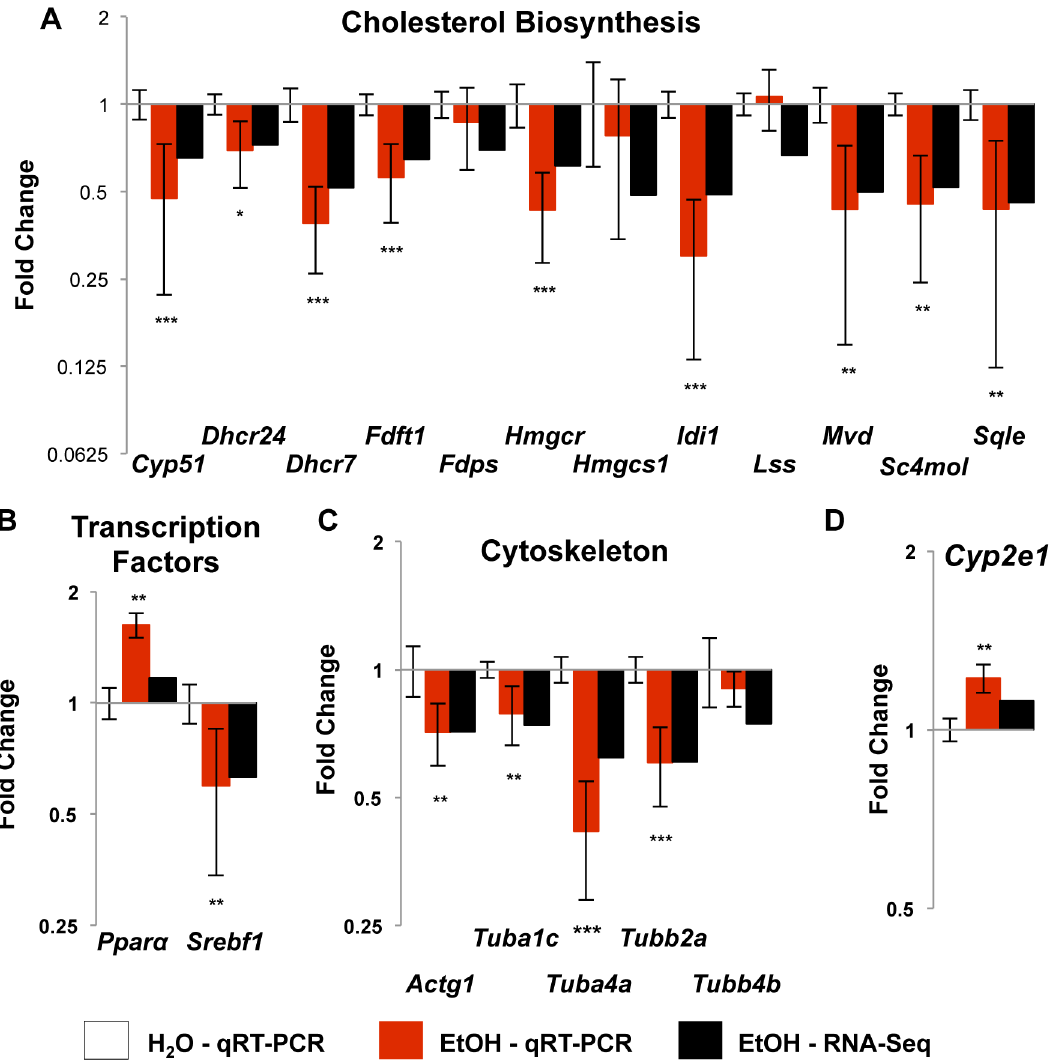
Fig. 3. Confirmation of altered expression by qRT-PCR in functional pathway genes. Taqman-based qRT-PCR was used to confirm the changes in gene expression. These graphs display the fold change ( ¡ SEM) of the candidate genes by qRT-PCR (red bars) and RNA-Seq (black bars) analysis for comparison. Numbers are relative to the water treated control rats (set at 1.0). ( A ) Nine of twelve genes in the cholesterol biosynthesis pathway were confirmed. ( B ) Ppar a , a transcription factor that activates genes for cholesterol oxidation was not significantly altered by RNA-Seq analysis, but was significantly up-regulated by qRT-PCR. Srebf1 , a transcriptioin factor that activates many genes in the synthesis pathway, was significantly decreased in both analyses. ( C ) Four cytoskeleton subunit genes were suppressed by RNA-Seq and qRT-PCR. ( D ) Cyp2e1 , a gene induced by chronic high levels of alcohol intake that mediates various alcohol-induced injuries was not induced when measured by RNA-Seq analysis, but was significantly up-regulated by qRT-PCR. * - p-value , 0.05, ** - p-value , 0.005, *** - p-value , 0.0001.